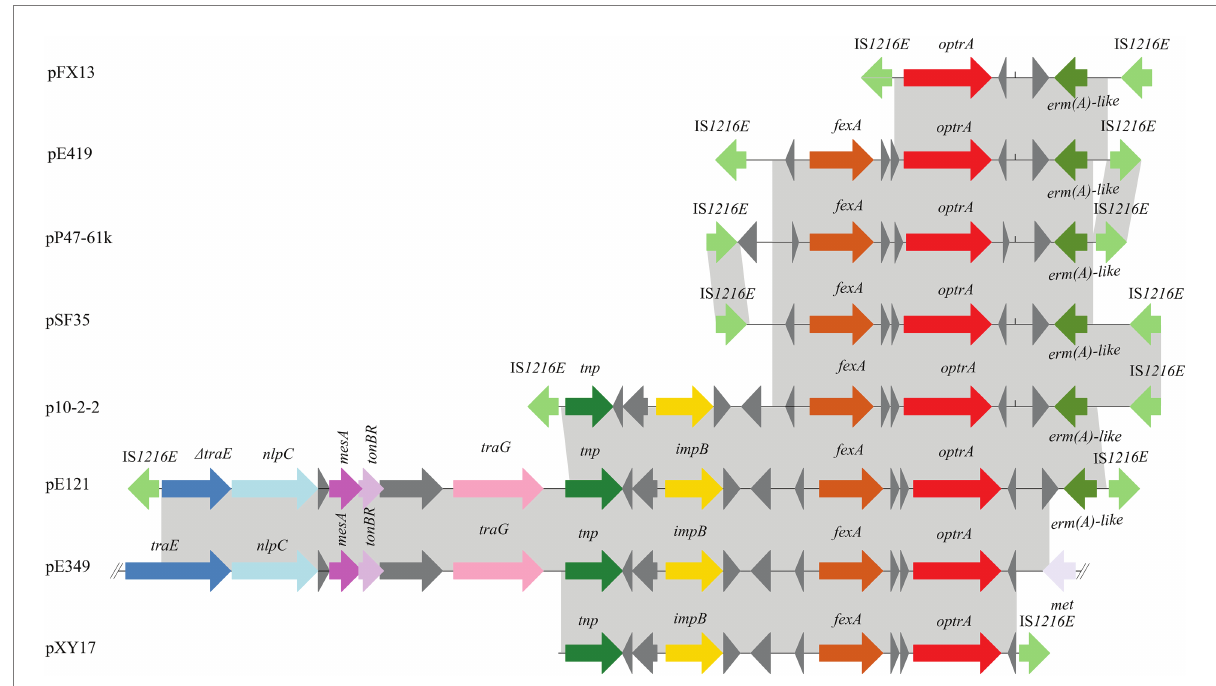
FIGURE 5 Schematic representation of the genetic environments surrounding the optrA gene in different sequences. The ORFs are shown as arrows, with the arrowhead indicating the direction of transcription. The same color represents the same elements and genes. Regions are drawn to scale. The sequences were retrieved from GenBank with accession numbers KT862775.1 (p10-2-2), T862776.1 (pE121), KP399637.1 (pE394), KT862777.1 (pE419), KT862778.1 (pFX13), KT862779.1 (pSF35), and KT862780.1